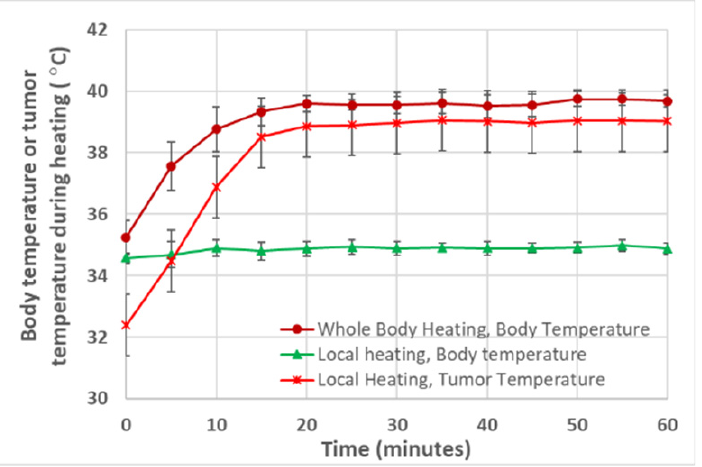
Figure 3. Typical temperature rising curves in the mouse body and tumor in the heating groups.